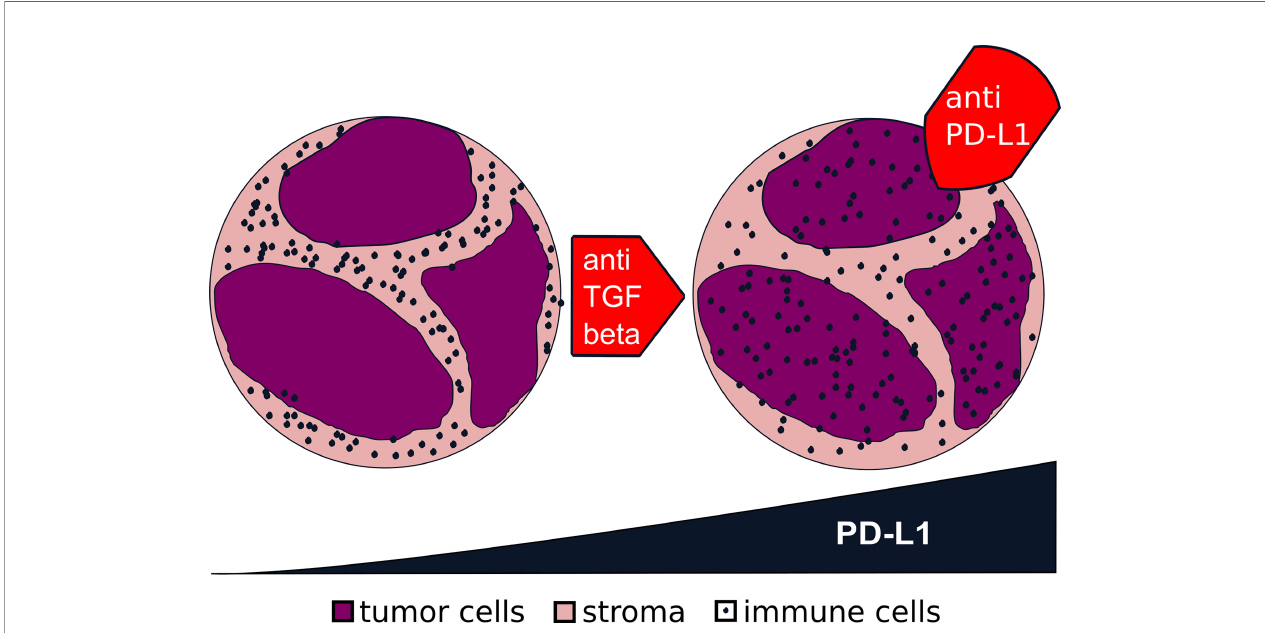
FIGURE 9 | Transformation from excluded to hot tumors via transforming growth factor beta (TGF- b ). From the data presented in this study, we generated the hypothesis for future studies: that a blockage of TGF- b in an excluded tumor ( left ) might turn it into a hot tumor ( right ). The higher expression of programmed death- ligand 1 (PD-L1) in a hot tumor might make it more prone to a blockage of the interaction of